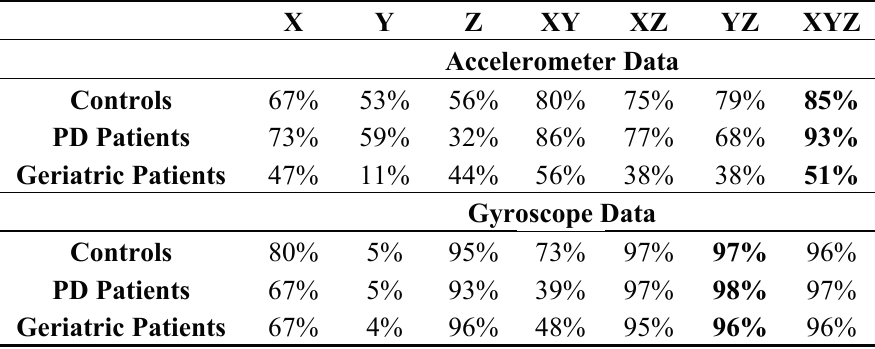
Table 2. Stride segmentation results for accelerometer and gyroscope data from 40 m walk from msDTW given in F-measure values. Best results for each subject group are highlighted in bold